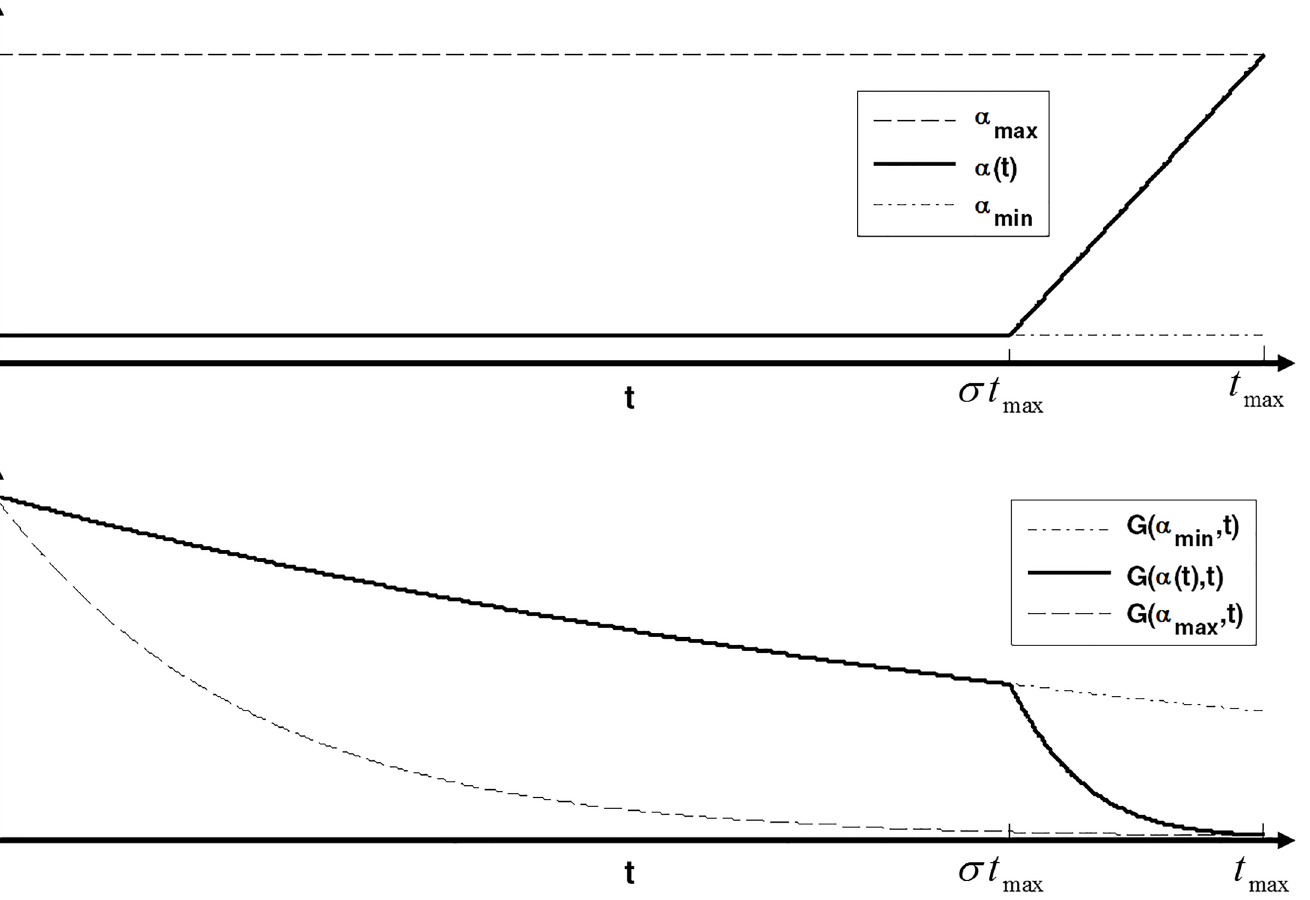
Fig 2. The variations of the proposed α (t) along with G(t)